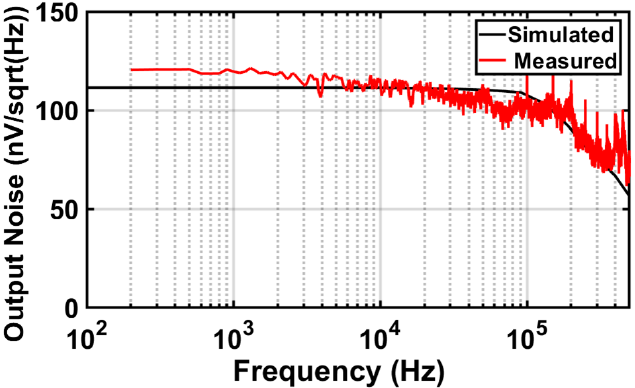
Figure 17. Simulated and measured FET detector noise voltage spectral density versus